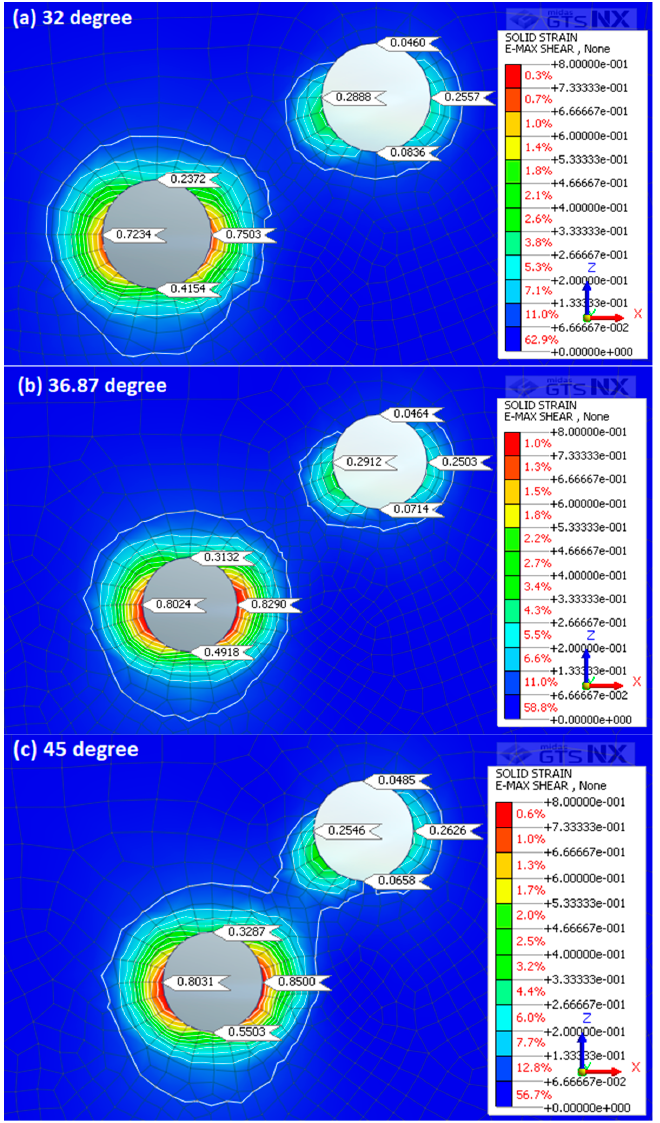
Figure 9. Effect of angular relative position on shear strain in the crown, invert, and springlines of twin tunnels at the end of excavation ( a – c ).